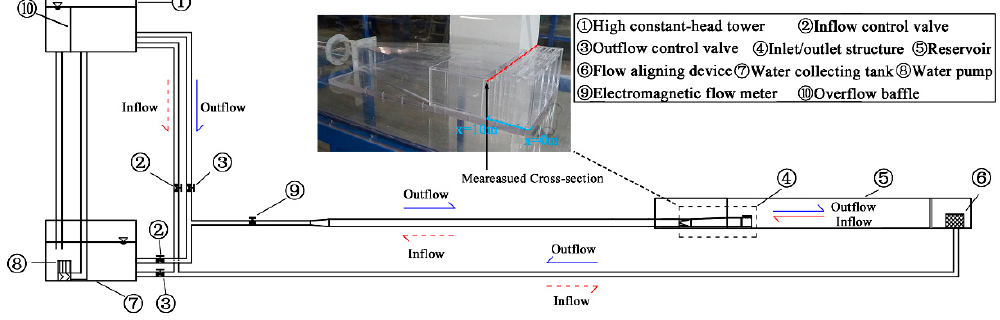
Figure 6. The side layout plan for the experimental system of the inlet / outlet.